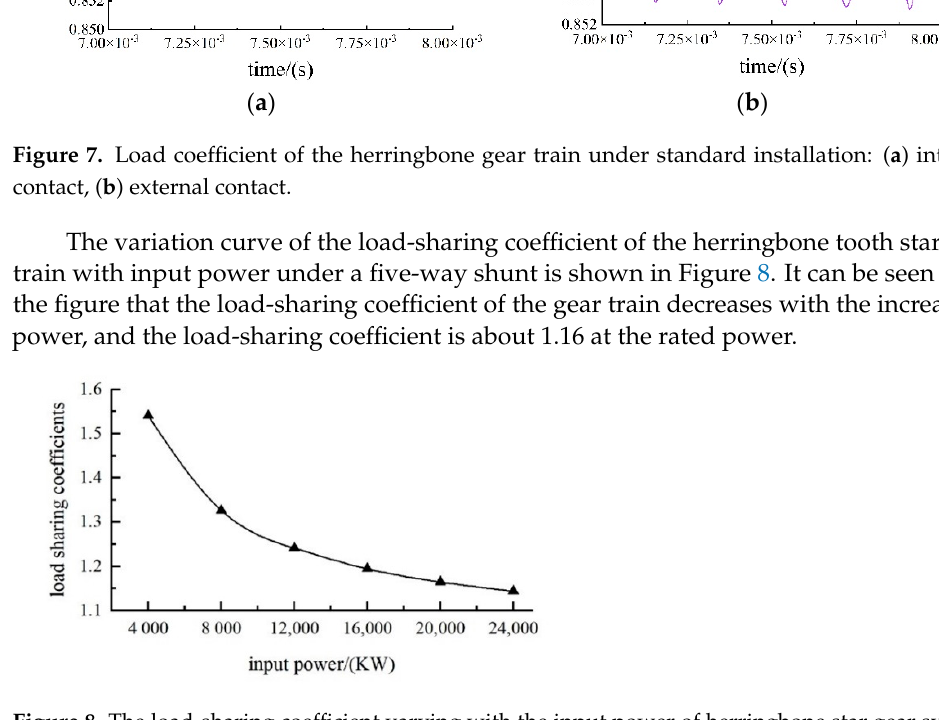
Figure 8. The load-sharing coefficient varying with the input power of herringbone star gear system.